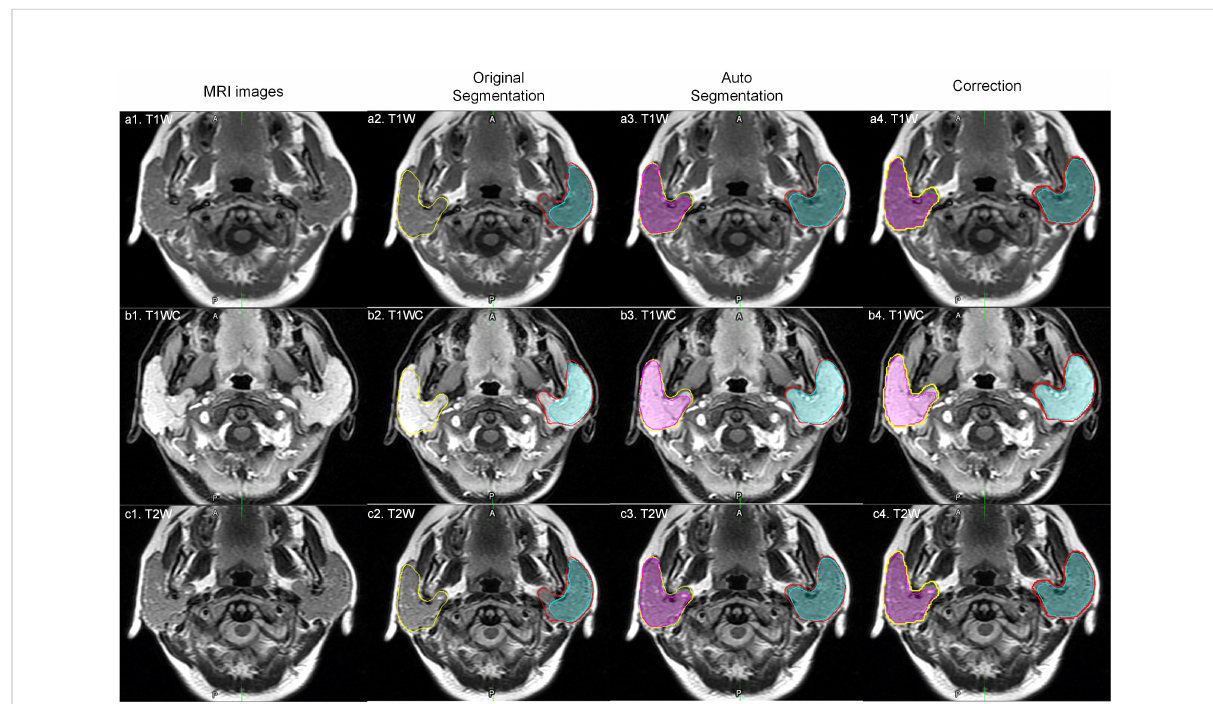
FIGURE 5 Anoutlier example. The yellow and red linesrepresent the right and leftparotid. The pink and cyan colored fi lling represents the right and left tumor. a1, b1 and c1 represent one sliceofMR images; a2, b2 and c2represent original manual segmentation. The right tumor was not delineated correctly; a3, b3 and c3represent the results of autosegmentation; a4,b4 and c4represent the corrected segmentationby manual delineationby